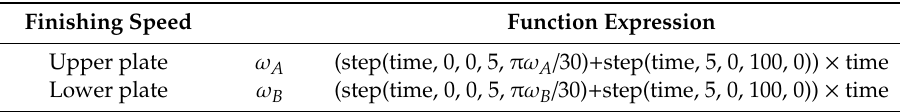
Table 8. Function expression of finishing speed.